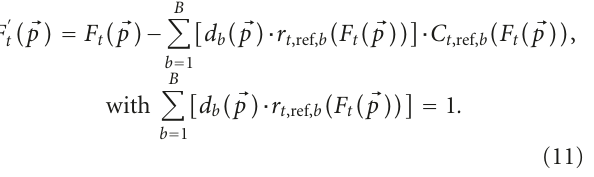
weights provide a good balance between the two. The final correction value is then given